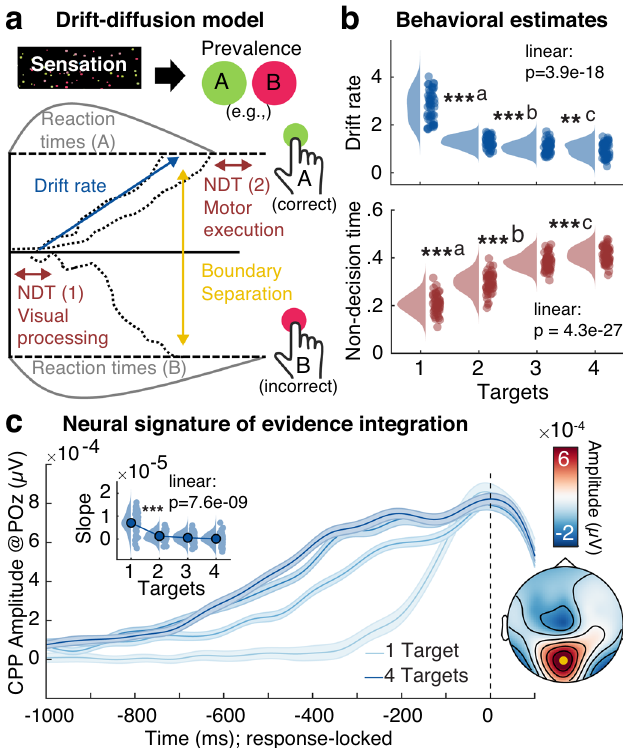
Fig. 2 Evidence integration upon probe presentation decreases as a function of prior uncertainty. a Schematic of drift-diffusion model. Following visual encoding, evidence is successively accumulated towards either of two bounds when probed for the dominant prevalence of one of two options of a single feature (e.g., color). A button press indicates the decision once one of the bounds has been reached and motor preparation has concluded. A non- decision time parameter captures visual encoding and motor preparation, drift rate captures the amount of available information, and boundary separation captures response bias (i.e., conservative vs. liberal). b Behavioral parameter estimates for drift rate and non-decision time (NDT; discussed in Supplementary Text 4), as indicated by the hierarchical drift-diffusion model (HDDM). Data are within-subject centered for visualization (see “ Methods ” ; drift: ***a: p = 2.9e − 16, ***b: p = 6.5e − 6, **c: p = 0.008, linear: b = − 0.57, 95% CI = [ − 0.65, − 0.49], t (46) = − 13.94; NDT: ***a: p = 5.6e − 11, ***b: p = 8.2e − 12, ***c: p = 0.0001, linear: b = 0.07, 95% CI = [0.06, 0.08], t (46) = 23.27). c Modulation of the centro-parietal positivity (CPP) as a neural signature of evidence accumulation (mean±within-subject SEM). The response-locked CPP indicates decreases in pre-response integration rate with increasing probe uncertainty. Insets show CPP slope estimates from − 250 to − 100ms relative to response execution (*** p = 7.2e − 8, linear: b = − 2e − 6, 95% CI = [ − 2.8e − 6, − 1.5e − 6], t (46) = − 7.05), as well as the corresponding topography (CPP channel shown in yellow). Panels b and c indicate p values from two-tailed paired t -tests, pairwise comparisons were Benjamini – Hochberg-adjusted for multiple comparisons. n = 47 participants for all panels. Source data are provided as a Source Data fi